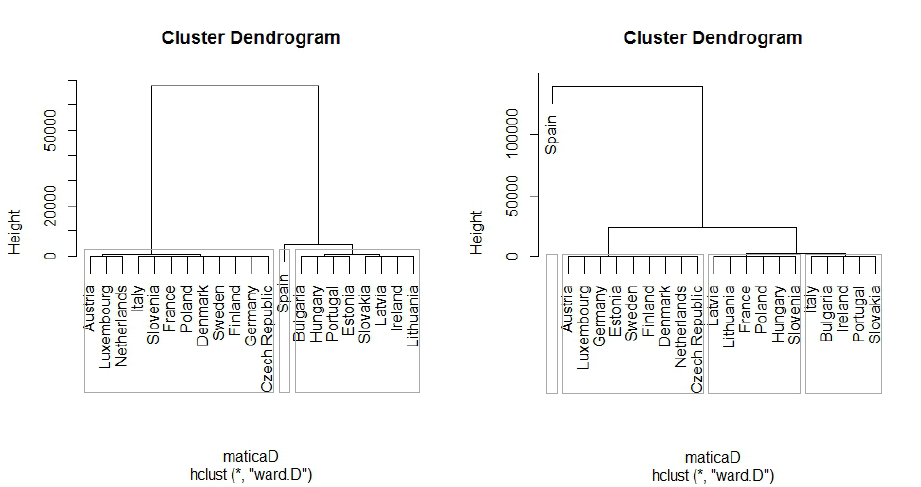
Fig. 6 – The dendrogram based on the selected variables in 2011 (left) and 2013 (right). Source: Own estimation (2017).